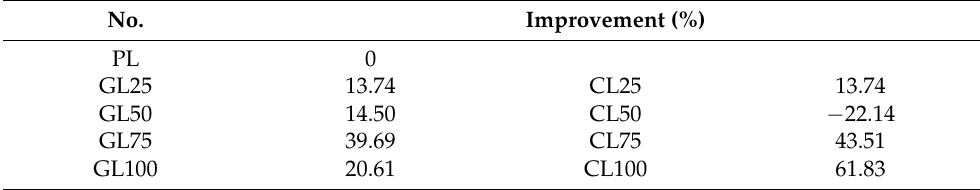
Table 8. Splitting tensile strength of grouted steel ball concrete. Table 9. Improvement of splitting tensile strength of grouted steel ball concrete.